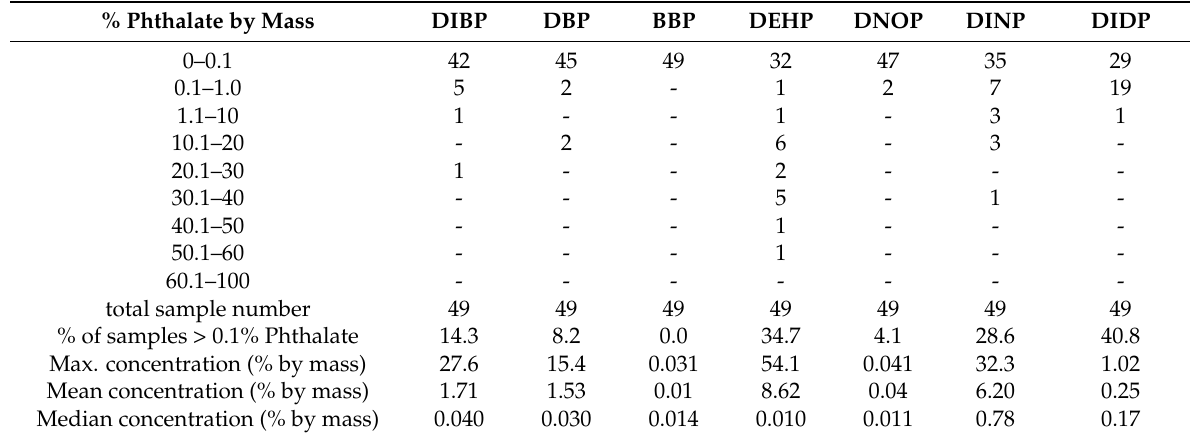
Table 3. Phthalate concentration ranges in children’s toys and maximum values.